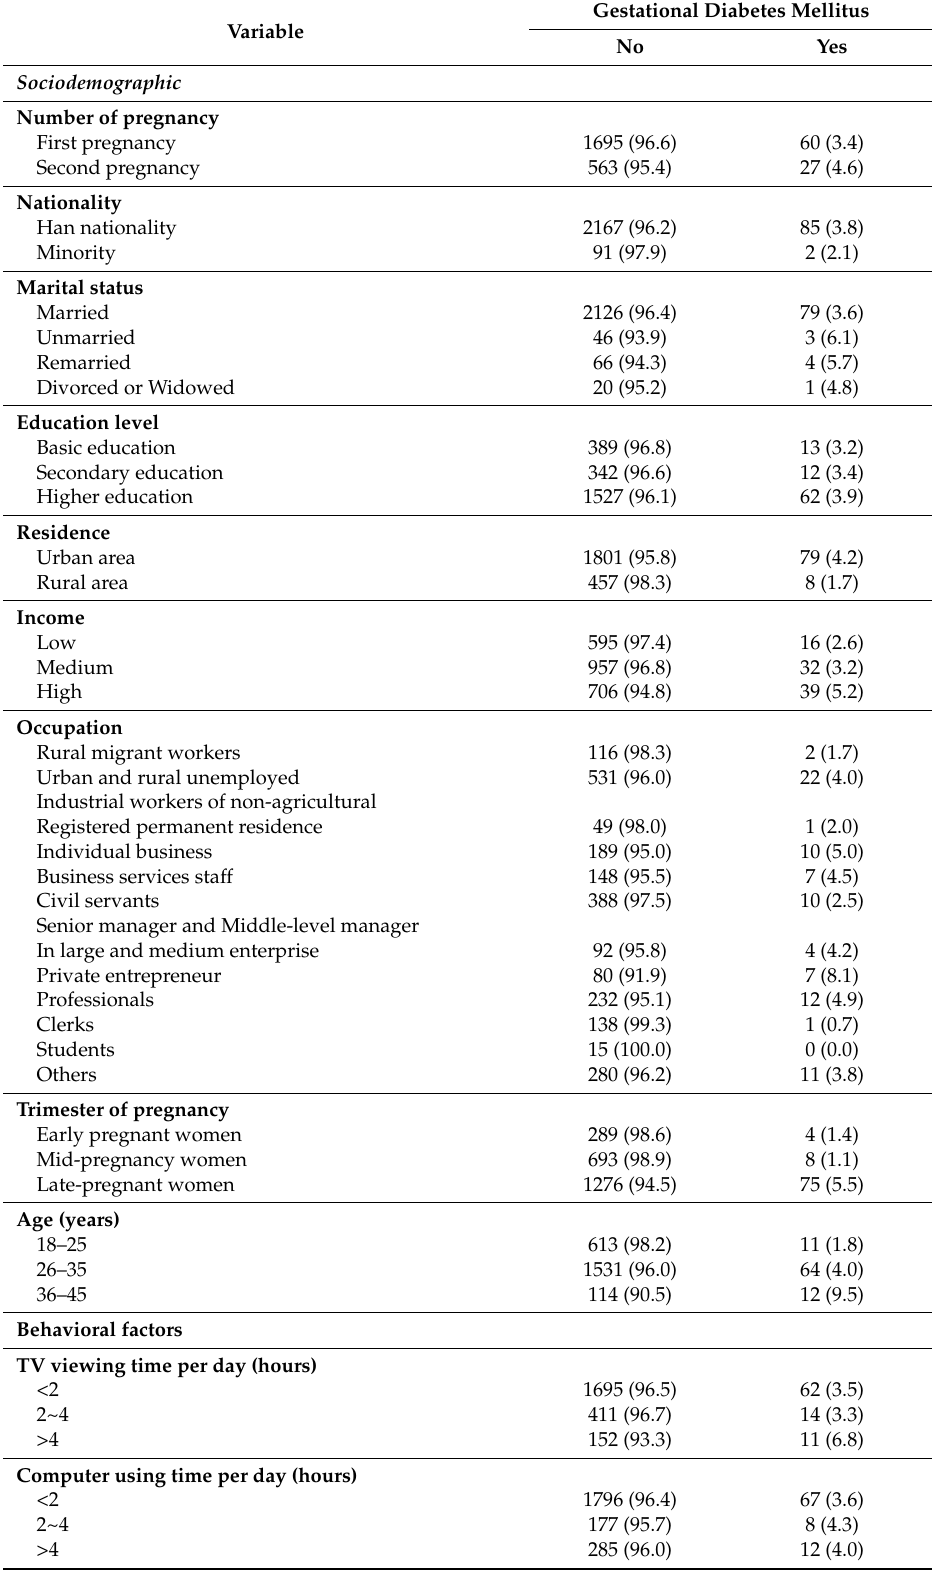
Table 1. Pregnant women stratified by gestational diabetes mellitus, China ( n ,